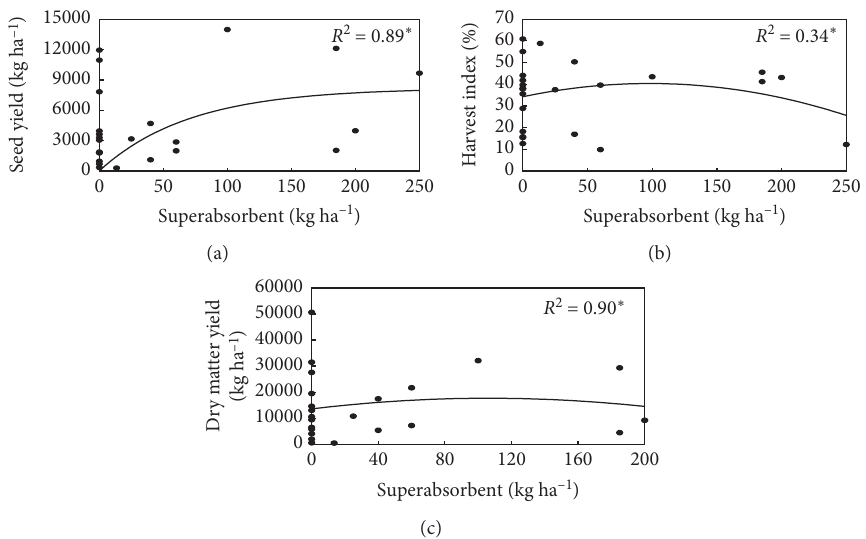
Figure 2: Response of seed yield, dry matter yield, and harvest index of crops to superabsorbent application